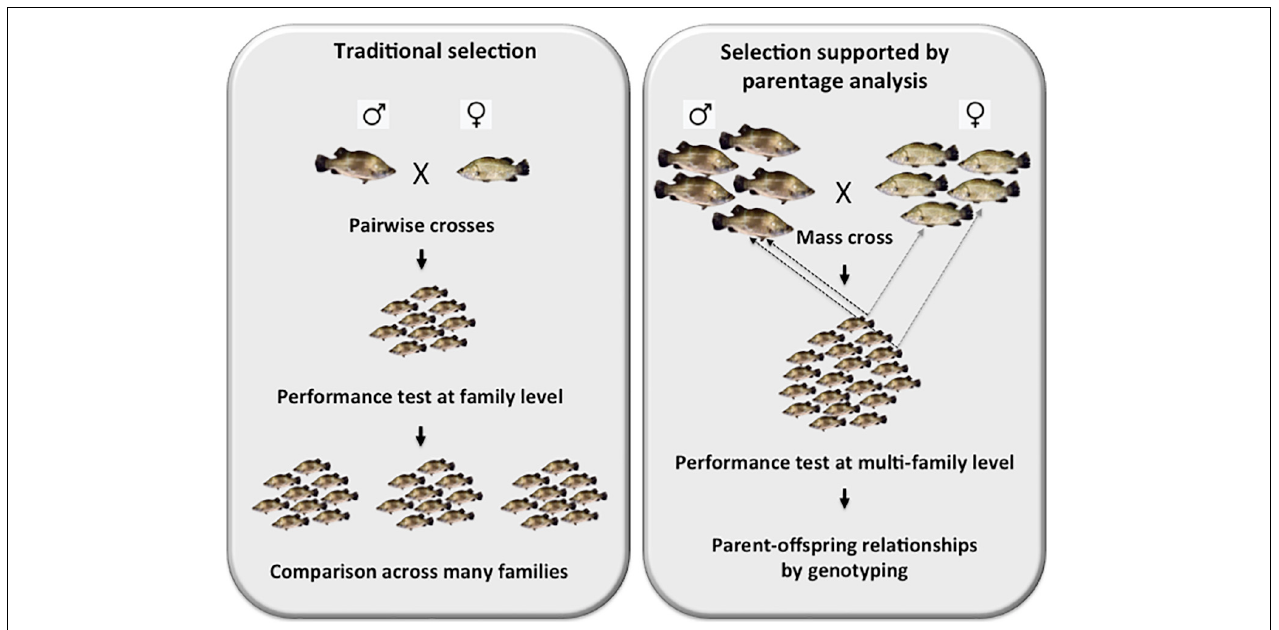
FIGURE 1 | Schematic representation of the differences between a family-based traditional selection vs. a modern selection program supported by parentage analysis. The left panel depicts a family-based selection, where selected pairs of brooders are crossed, their offsprings are raised together and their performance analysis is performed by comparing siblings within the family. In this approach, many families must be analyzed individually and often repeatedly as environmental effects can have a substantial effects on the results of these comparisons. On the right panel, the essence of a modern selection program supported by parentage analysis based on genotyping with polymorphic DNA markers is shown. In this protocol, mass crosses involving up to 25 males × 25 females are performed. Following the validation of multi-family contribution by microsatellite-based genotyping, offspring are raised together to the age, when their performance can be assessed. The best-performing offspring individuals are then fin-clipped and genotyped with multiplexed microsatellite sets to reveal their parents. The brooders are then crossed again to (i) validate the results of the first cross; and (ii) possibly generate new families with even better results.